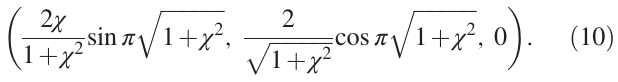
The theoretical closest approach to cos μ at G γ ¼ 45 . 5 , is with χ ¼ 1 . 0225 , yielding B 0 ¼ 4 . 569 T